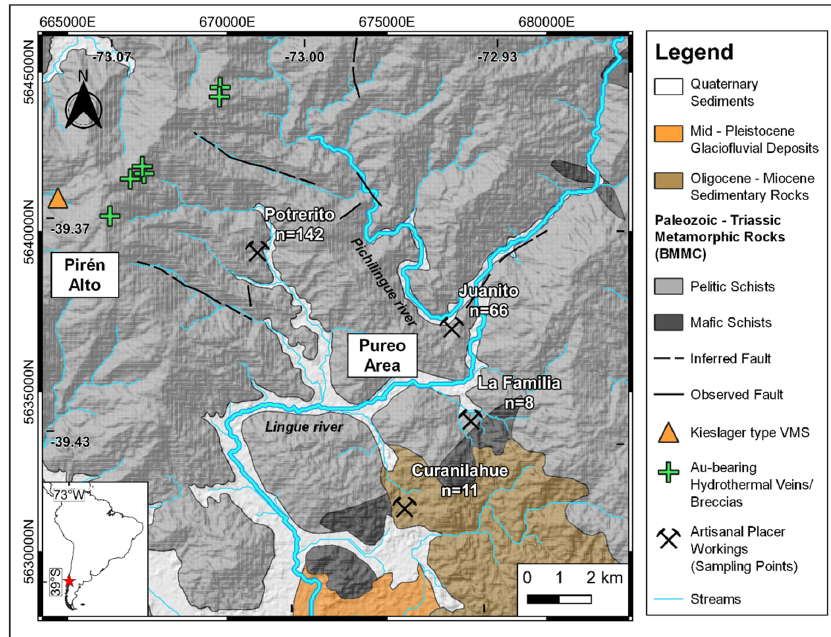
Figure 1. Geological map of the Pureo area. Hypogene mineralizations and active placer artisanal workings with the respective samples are shown. BMMC: Bahía Mansa Metamorphic Complex (modified after [12,13,16,18–20]).